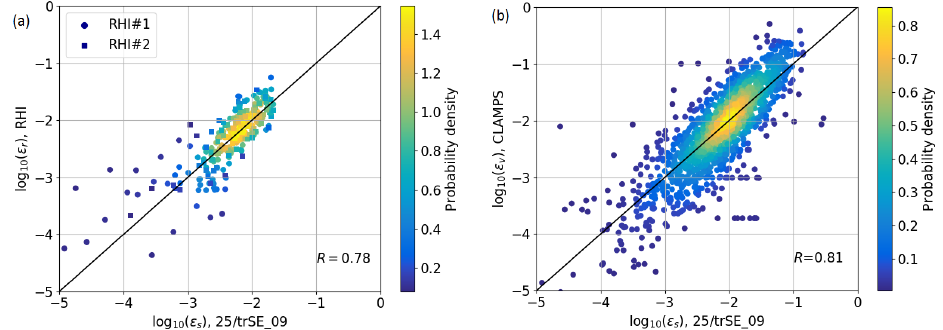
Figure 7. Comparison of half-hour averaged estimates of ε at 100m above ground between the sonic anemometer on tower 25/trSE_09 and the RHI measurements (a) and for the same sonic anemometer and CLAMPS (b) . The color scales represent the density of probability of a measurement point. The black line is the line of